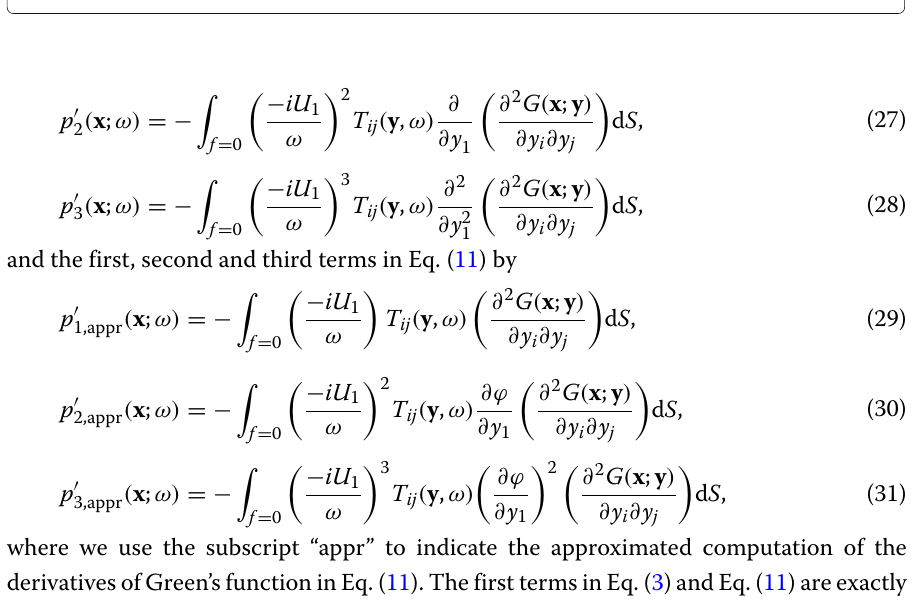
Fig. 3 Comparison of the quadrupole correction ( I Q ) to the errors produced by the FW-H